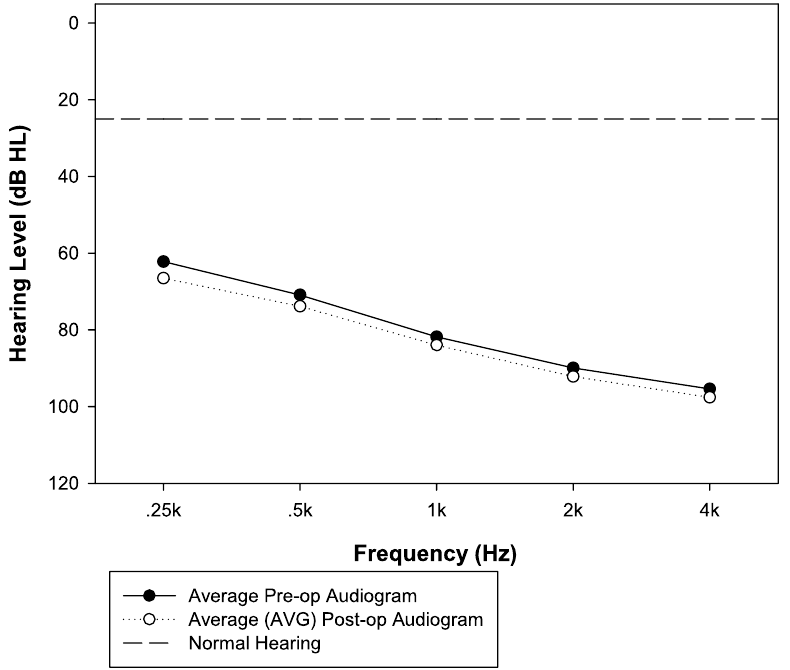
Figure 1. Group mean of preoperative and average postoperative unaided